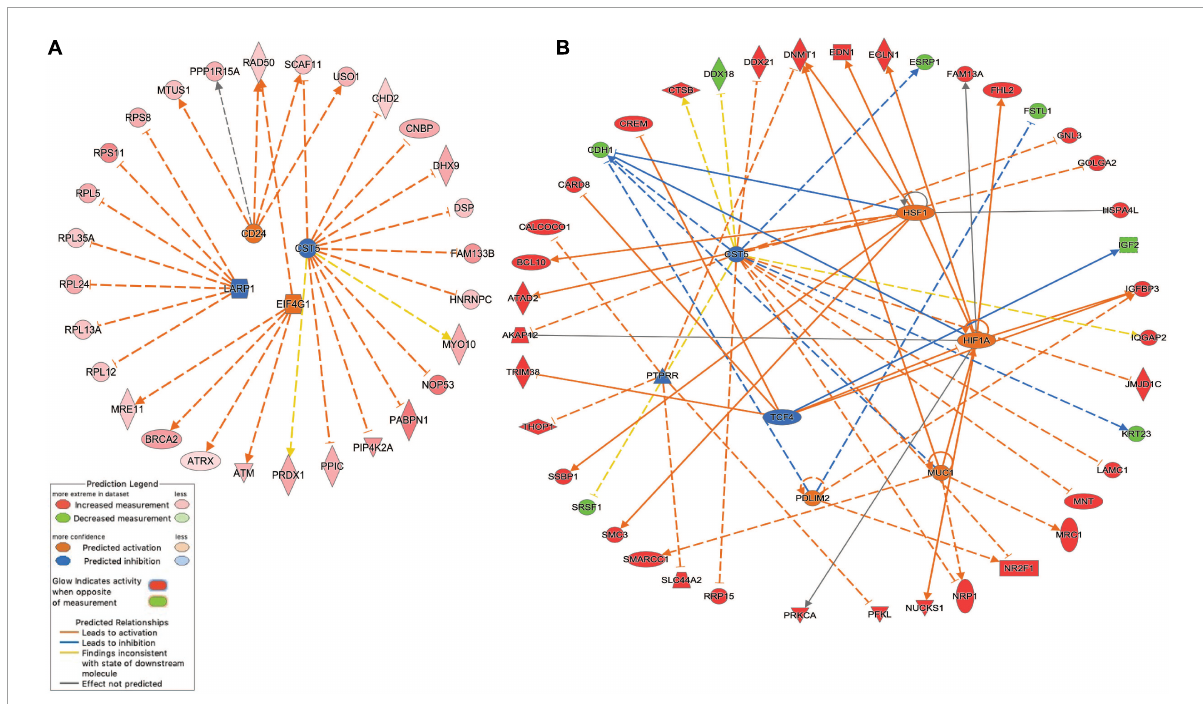
FIGURE3 Inhibited/activated upstream regulators and their target genes. (A) An integrated network among the common set of cerebral white matter associated genes ( n = 244) that includes La ribonucleoprotein 1 ( LARP1), CD24 molecule (CD24) , Cystatin D ( CST5), and eukaryotic translation initiation factor 4 gamma 1 ( EIF4G1); (B) An integrated network among the echolucency unique genes (n = 381 ) that includes CST5, Hypoxia-inducible factor 1-alpha ( HIF1A ), mucin 1, cell surface associated ( MUC1 ), PDZ and LIM Domain 2 ( PDLIM2 ) , PTPRR, and transcription factor 4 ( TCF4 ) 1. All the target genes were differentially expressed based on the meta-analysis. For example, the activation of EIF4G1 leads to the overexpression (indicated by the orange arrow line) of alpha thalassemia/mental retardation syndrome X-linked ( ATRX ) (indicated by the red color). For other indicators, please refer to the Prediction